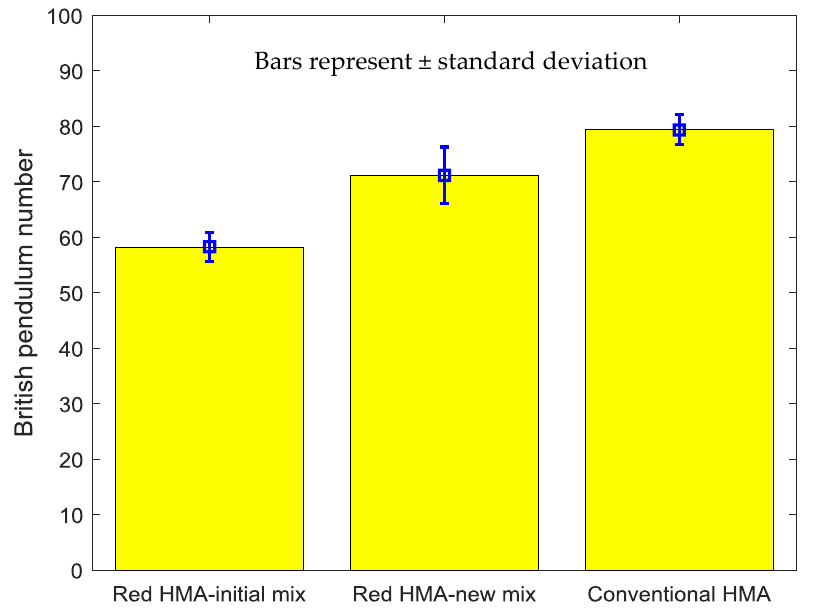
Figure 4. Pavement frictional values of tested sections.